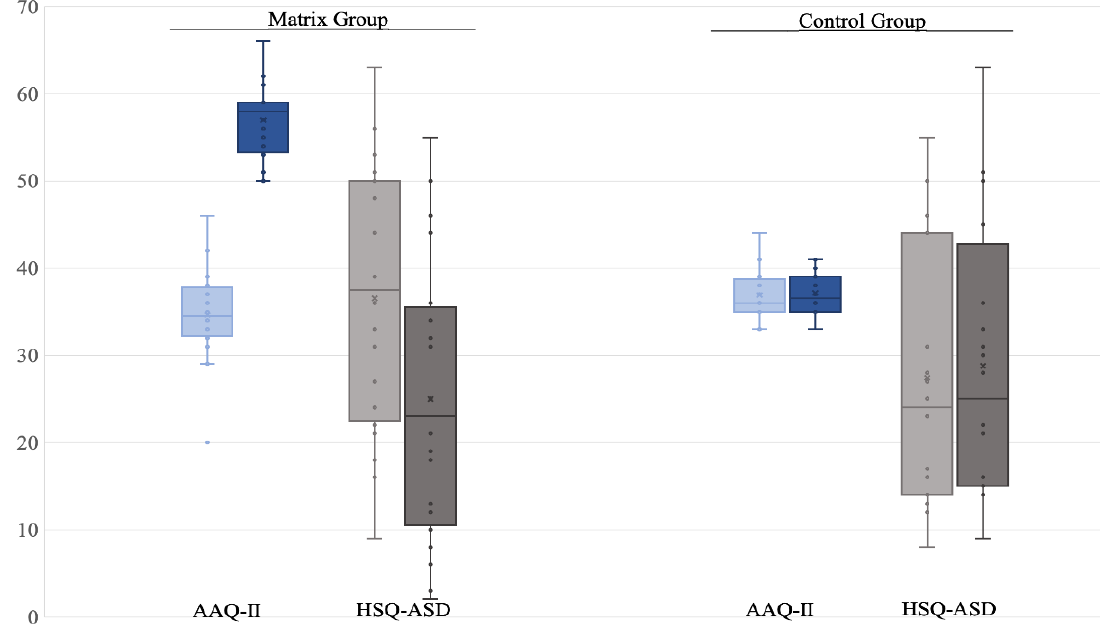
Figure 3. Pre- and post-intervention comparison between and within groups on primary outcome measures. Pre-intervention: in each block, on the left, drawn with lighter colors. Post-intervention: in each block, on the right, drawn with darker colors. Table 3. Pre- and post-intervention comparisons in outcome measures for matrix and Parent Training